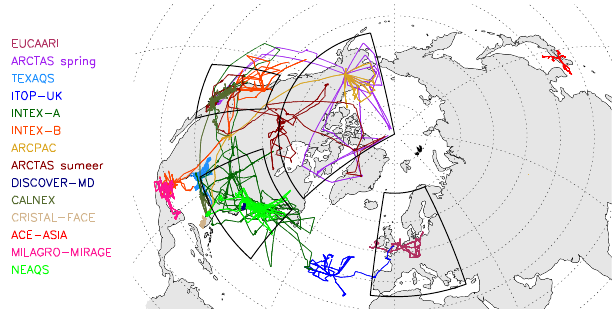
Figure 3. Flight tracks of 14 flight campaigns used in this study